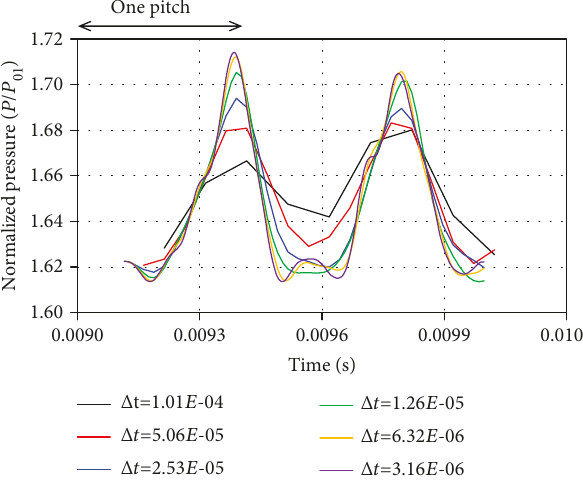
Figure 3: Solution dependency on the time step at the impeller